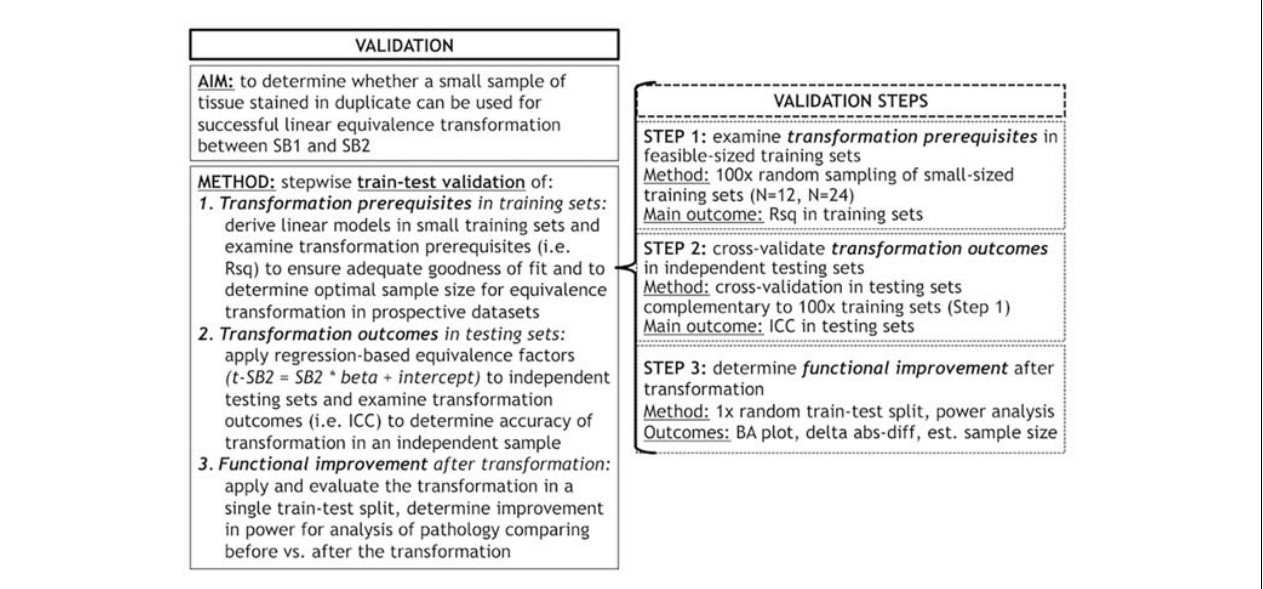
FIGURE 1 | Objectives and methods of this validation study and stepwise validation protocol. Panel outlines the aim and methods of our validation study to account for staining batch effects in digital pathology, including a stepwise protocol to assess relevant aspects of our proposed methodology. delta abs-diff, change in absolute difference; est. sample size, estimated required sample size in a power analysis; ICC, intraclass correlation coefficient; N, number of tissue samples; Rsq, R squared; SB1, staining batch 1 (original); SB2, staining batch 2 (new); t-SB2, transformed staining batch 2 (new).